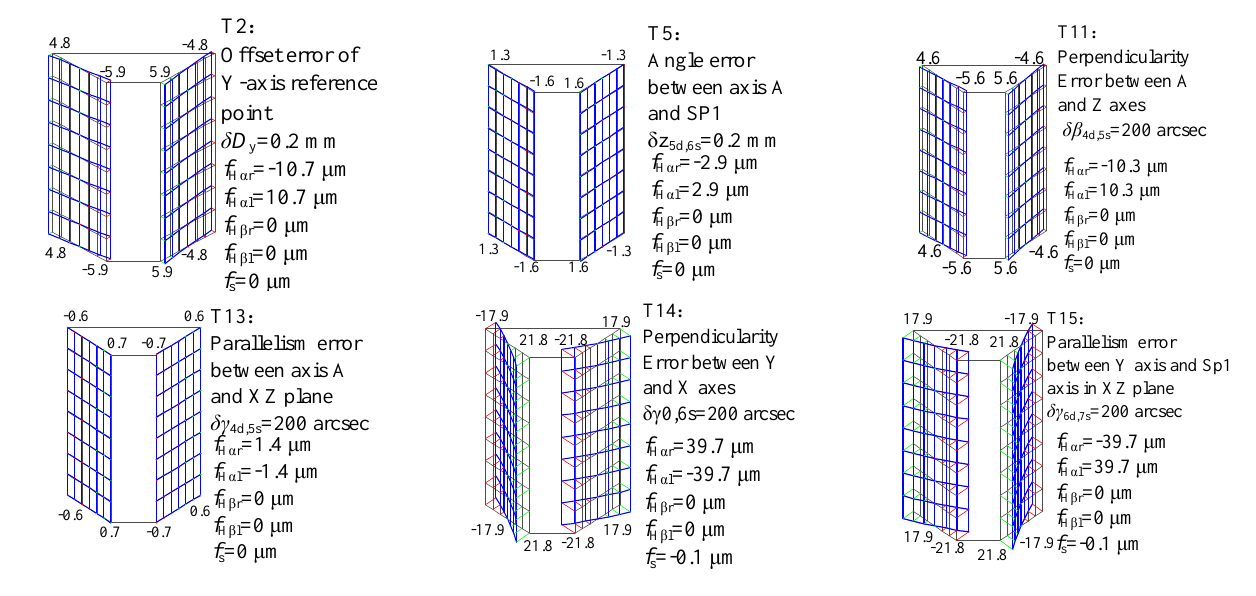
Figure 9. Deviations in tooth surface produced by assembly errors T2, T5, T11, T13, T14, and T15.